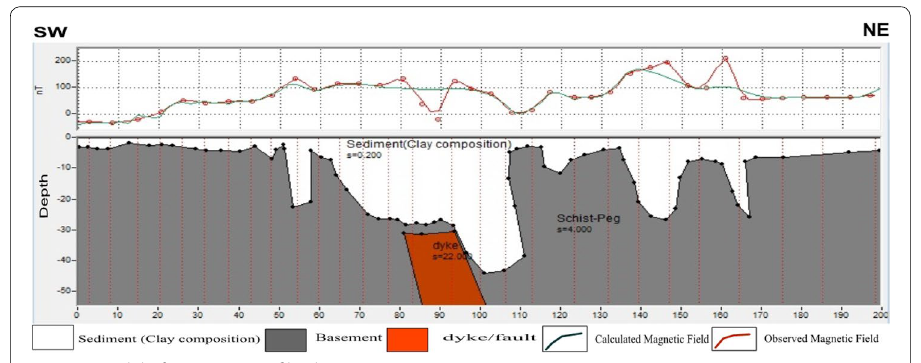
Fig. 14 Model of magnetic profile along traverse